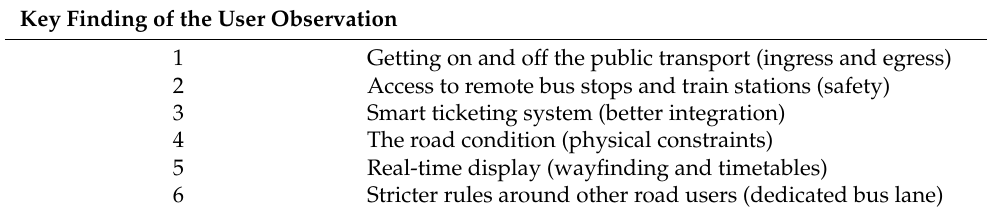
Table 1. Key findings of the user observation in KL,